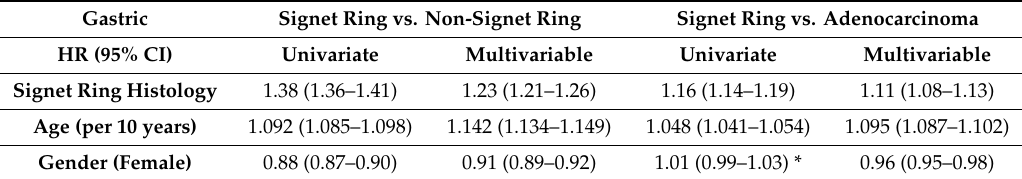
Table 2. Derived univariate and multivariable Cox-proportional hazard ratios (HR) of mortality for gastric